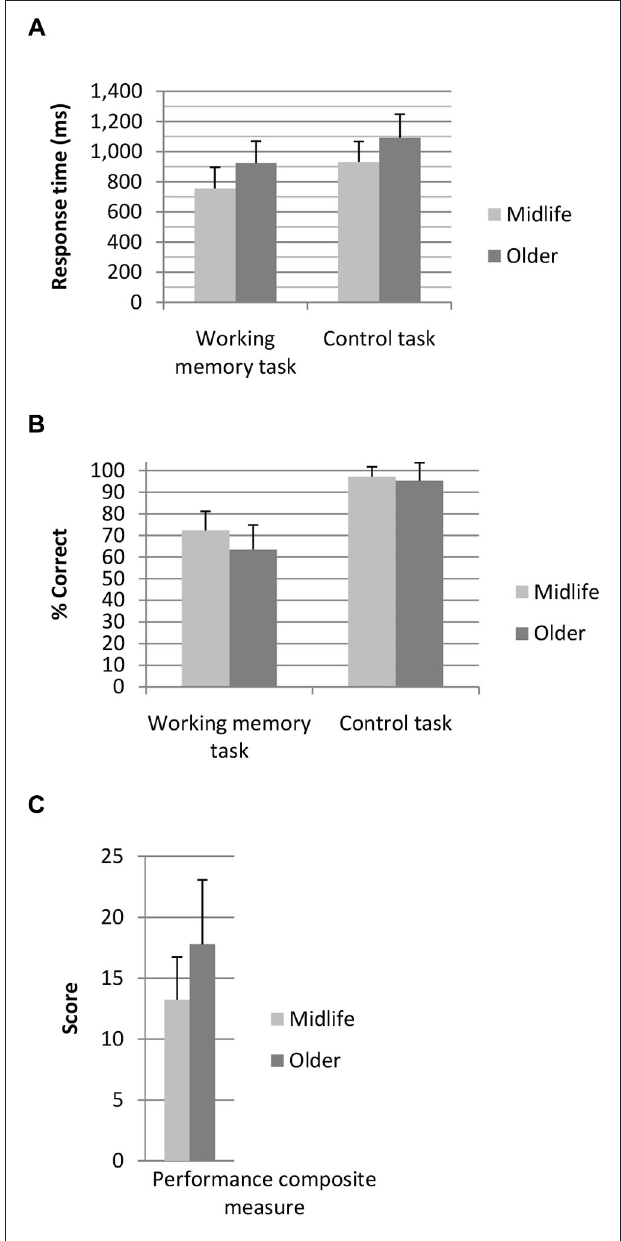
FIGURE 2 | (A) Response time and (B) percentage correct for the working memory and control tasks and (C) combined performance score for the working memory task. Performance composite score, where lower score indicates superior working memory